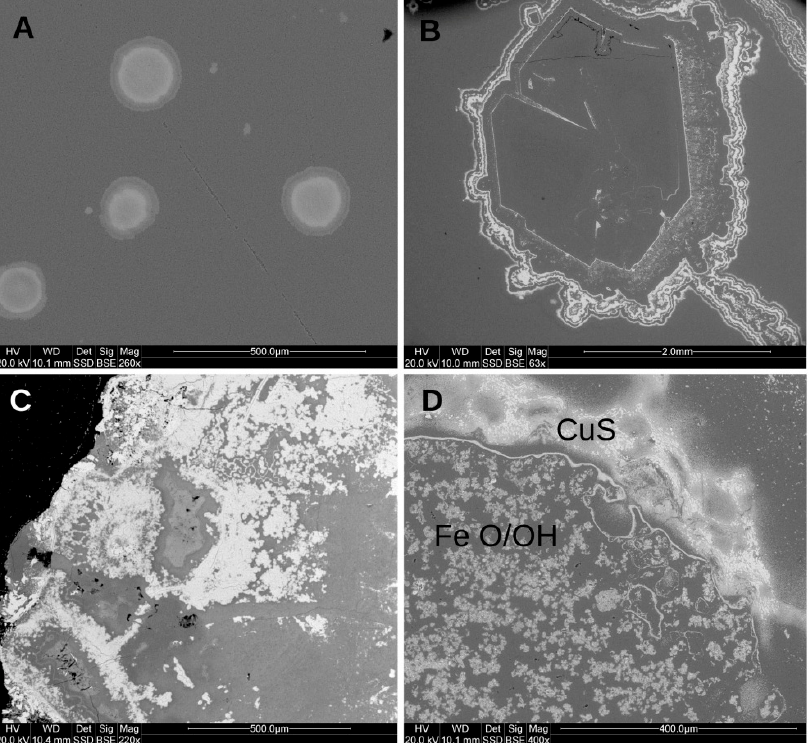
Figure 4. Backscattered electron (BSE) images of Fe compounds forming different aggregates ( A , B , C ) and locally accompanied by Cu sulphides ( D ) in agates from Kerrouchen.